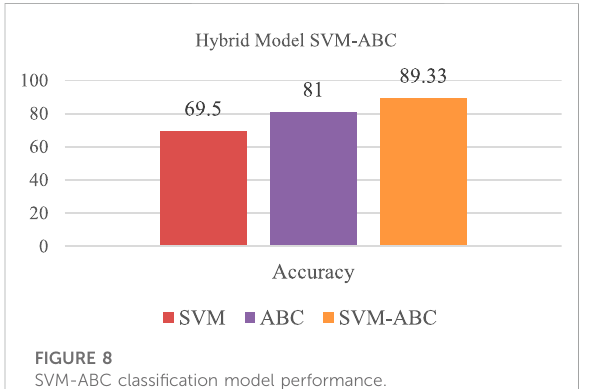
FIGURE 10 Classi fi cation Model.SVM-CBC